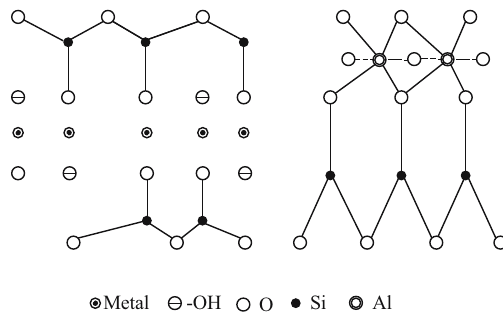
Figure 5: Short - range structural sketch